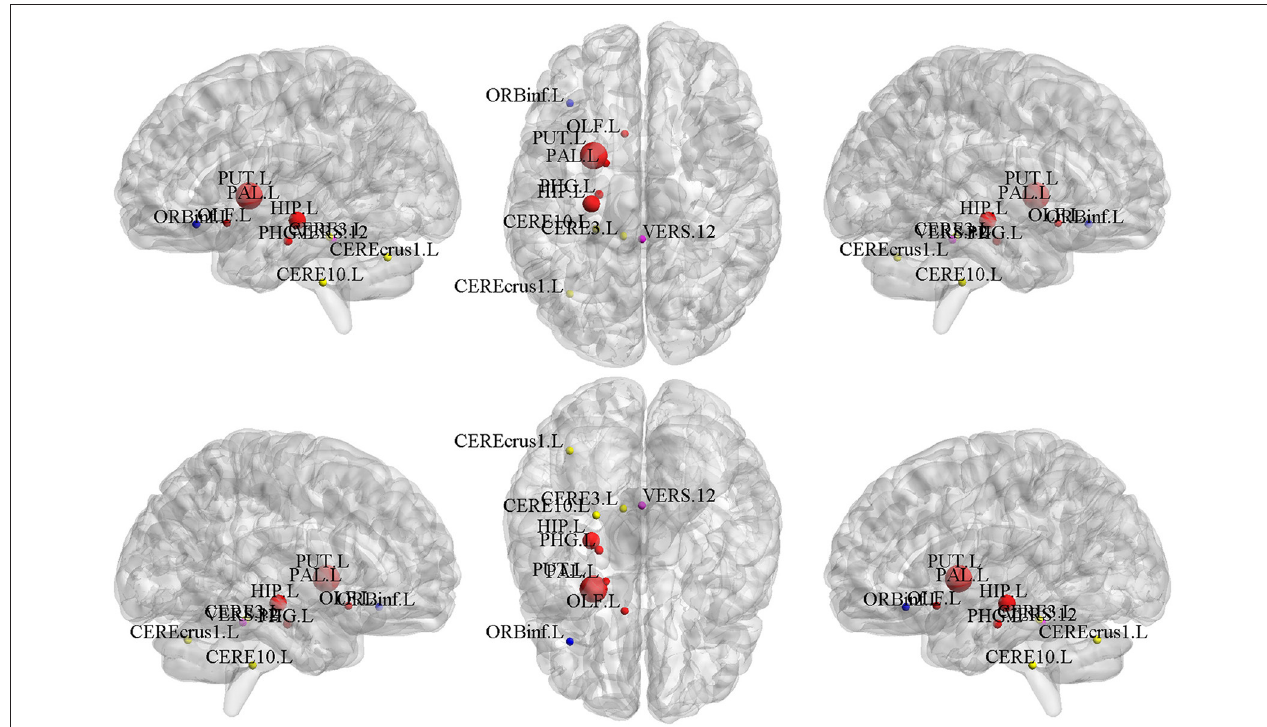
FIGURE 5 | The top 10 ROIs of d-fALFF selected by BN-MSCCA (different colors denote different brain networks).